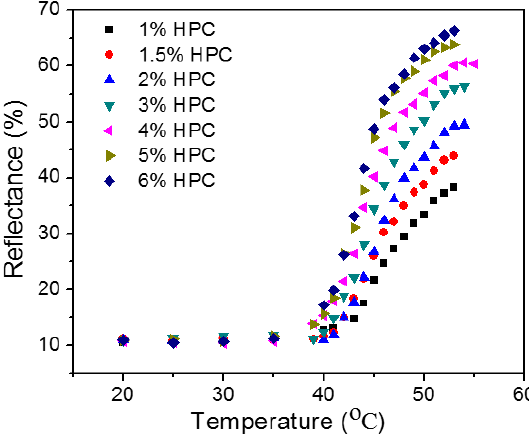
Figure 7. The reflectance of 6 wt. % HPC in aqueous solution under various temperature conditions. Upon increasing HPC concentration in aqueous solution from 1 wt. % up to 6 wt. % HPC, reflectance was also observed to increase, as can be seen in Figure 8.